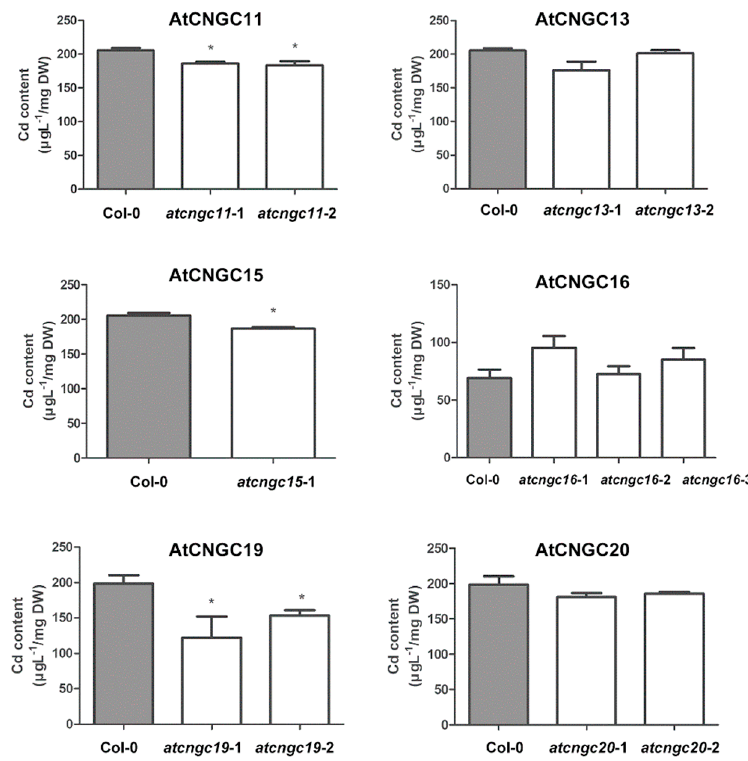
Figure 5. Cd 2+ content in Arabidopsis plants grown on an agar medium with Cd 2+ . All of the seedlings used to measure primary root growth in three replicated experiments were combined and extracted in 60% ( v / v ) HNO 3 . Elemental analysis was conducted utilizing an ICP-MS System. Data presented represent the mean ± SEM ( n = 3). T-tests were conducted to compare the concentration of each element in cngc mutants vs. wild-type plants. * and ** symbols indicate significant differences at p > 0.05 and p > 0.01, respectively.